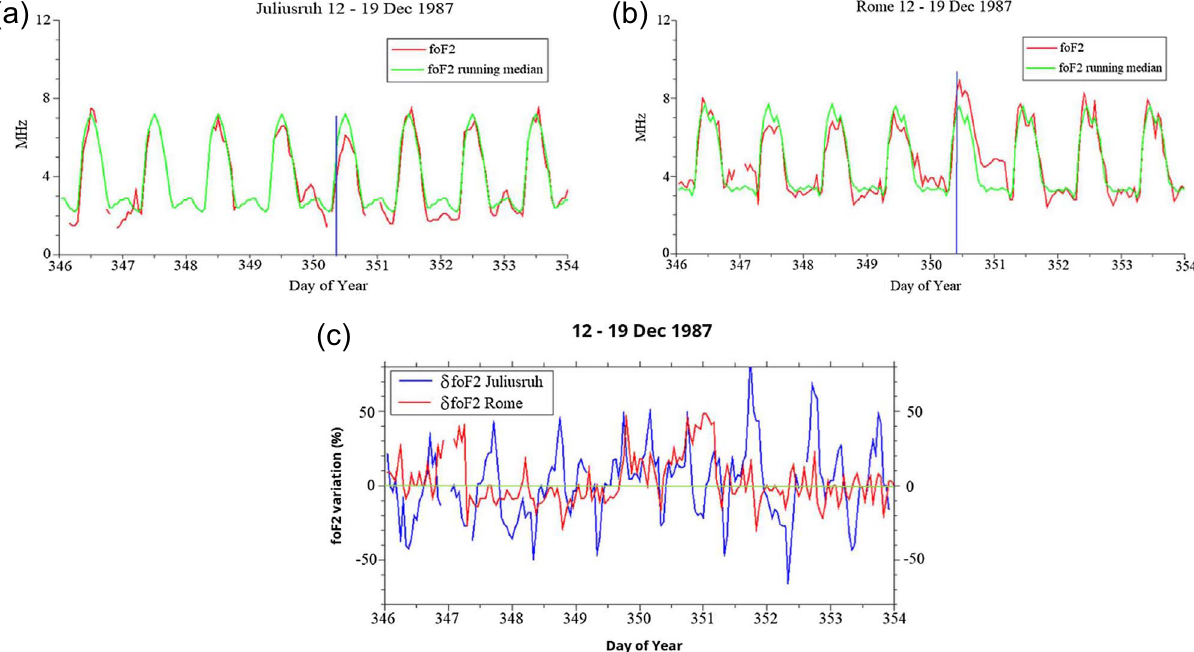
Fig. 9. In panel (a), the red line represents the hourly values of foF2, recorded at Juliusruh ionospheric station from 12 to 19 December 1987. The green line represents the foF2 running median here considered as background value of the ionospheric parameter. In panel (b) the same parameters, recorded by the Rome ionospheric station, are reported, considering the same time period. In panel (c) is reported the variation in percentage of the foF2 for the two ionospheric stations, for the considered